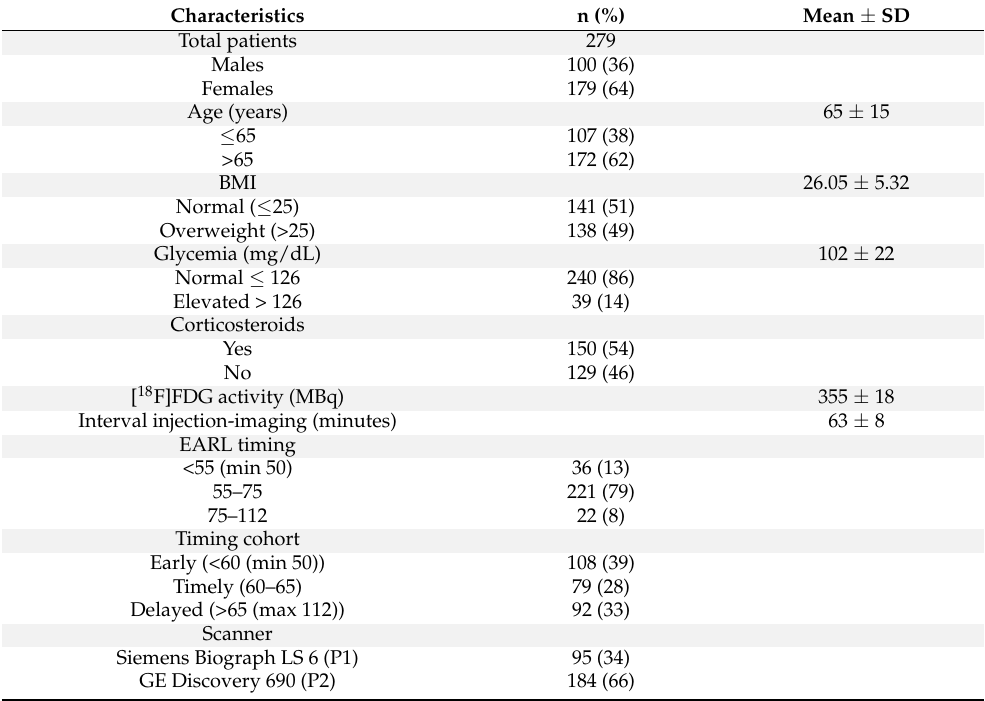
Table 2. The patients’